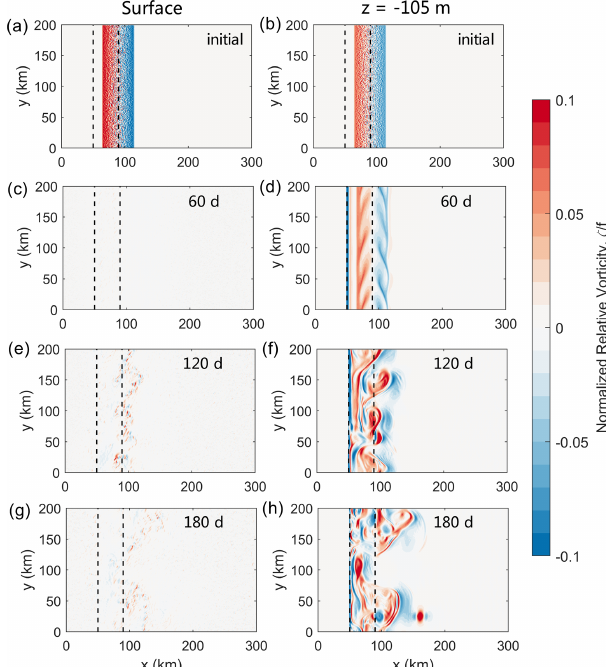
Figure 4. Distributions of the relative vorticity ζ = ∂v/∂x − ∂u/∂y normalized by f at t = 0 , 60, 120, and 180d from Exp-PD: (left) at the surface and (right) at the depth of − 105m. The region of the continental slope is outlined by two dashed black lines in each